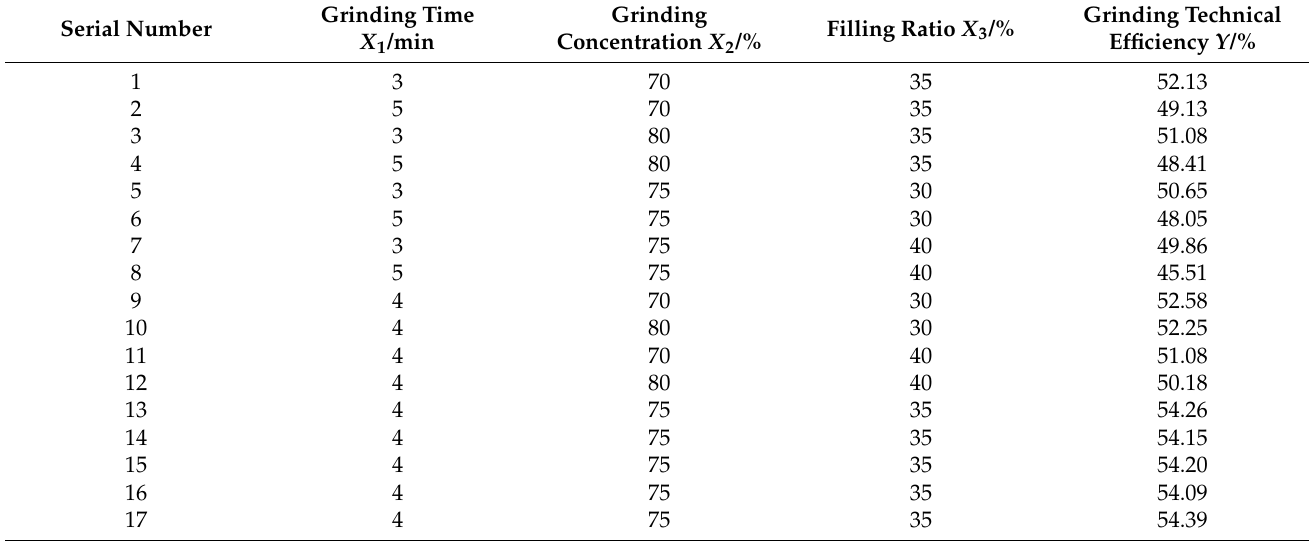
Table 17. Experimental design and result of response surface